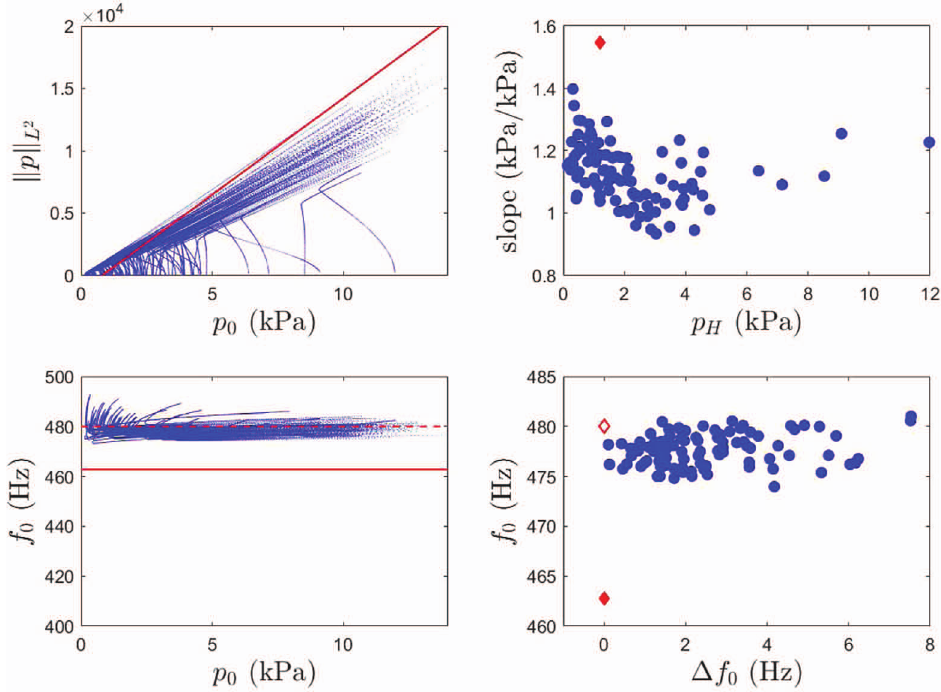
Figure 9. Left: 100 bifurcation diagrams obtained from random variations of the lip parameters around the values given in Table 2, the plain red lines are the targets obtained from human performance. The dashed line on the bottom plot corresponds to the modi fi ed target. Top right: mouth pressure at Hopf bifurcation and slope calculated from 100 linear regressions performed on the stable sections of the 100 bifurcation diagrams, the red diamond corresponds to the red line in the left plot. Bottom right: D f 0 and f 0 obtained from the 100 bifurcation diagrams, the plain red diamond correspond to the red line in the left plot. The empty red diamond corresponds to the modi fi ed